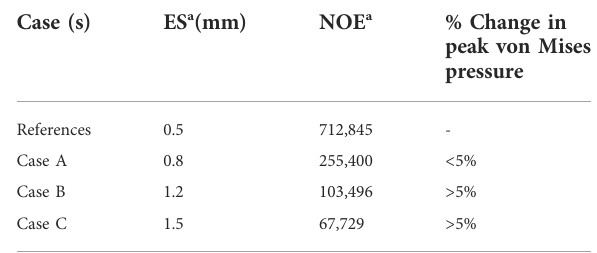
TABLE 1 The mesh convergence